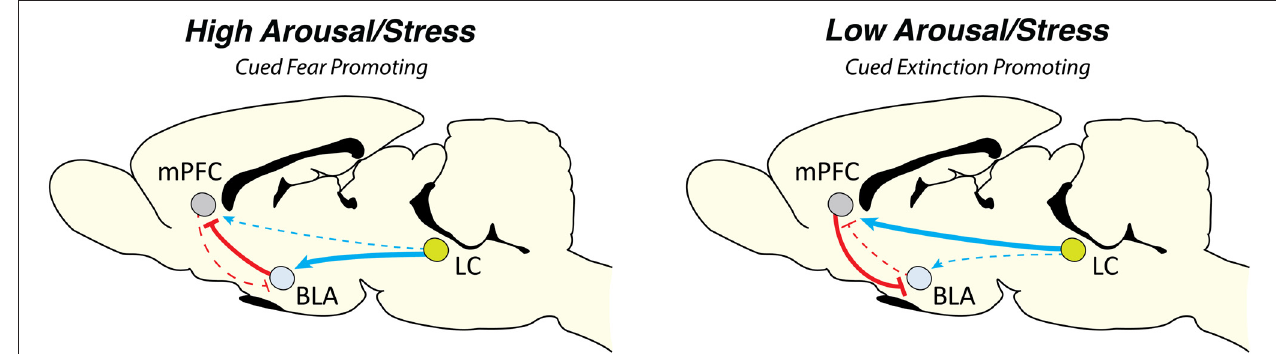
FIGURE 1 | Locus coeruleus norepinephrine (LC-NE) dynamically regulates cued aversive learning and memory. We propose a model by which the LC-NE system can dynamically regulate cued Pavlovian fear conditioning and extinction based on the prevailing level of stress at the onset of learning. Under high levels of arousal the LC-NE system acts via α 1 and β -ARs, a state that would favor elevated levels of fear and hinder new learning (for example, in the case of immediate extinction). High levels of stress may act to increase BLA function while simultaneously impairing mPFC output which is necessary for extinction learning. In contrast, under low levels of arousal, LC-NE acts via α 2-ARs in both the BLA and mPFC. This scenario would likely promote new learning (particularly extinction learning) by leaving mPFC function intact. Arrow width indicates projection strength. Abbreviations: mPFC, medial prefrontal cortex; BLA, basolateral complex of the amygdala; LC, locus